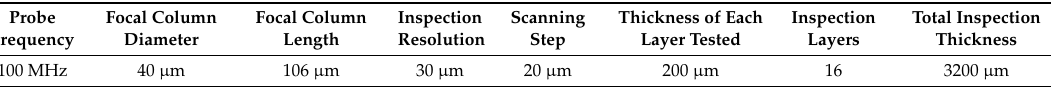
Table 1. Ultrasonic testing parameters for each sub-specimen.